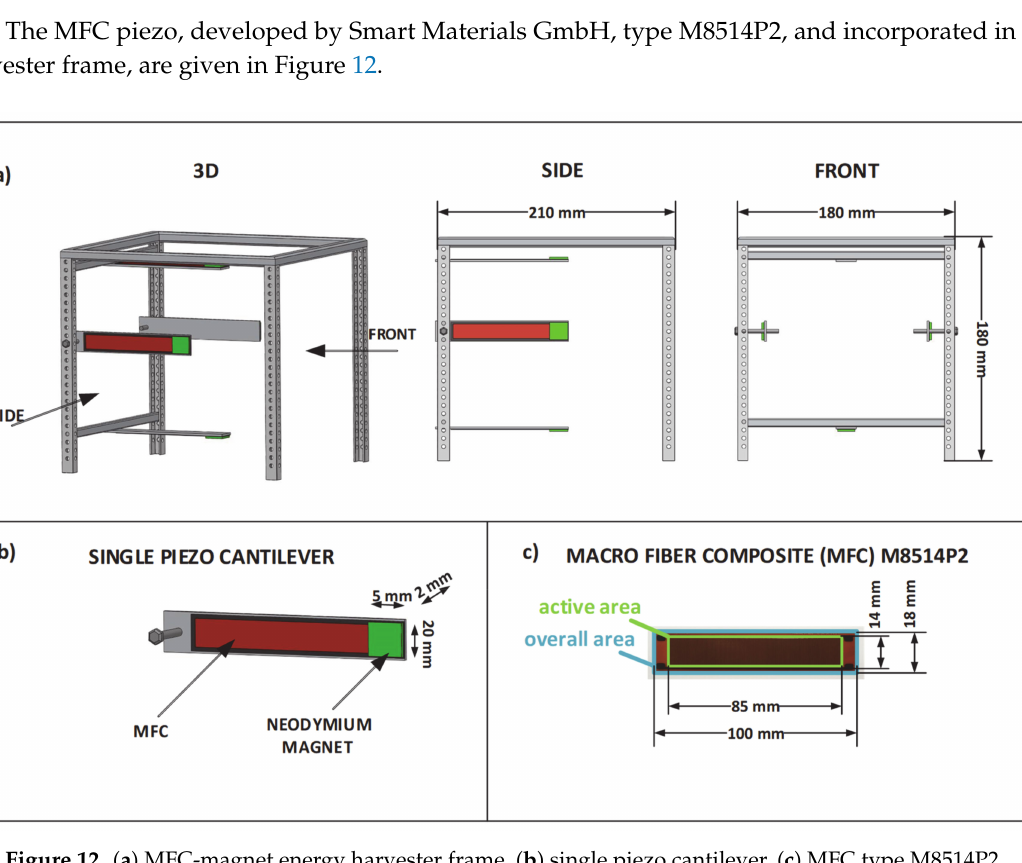
Figure 12. ( a ) MFC-magnet energy harvester frame, ( b ) single piezo cantilever, ( c ) MFC type